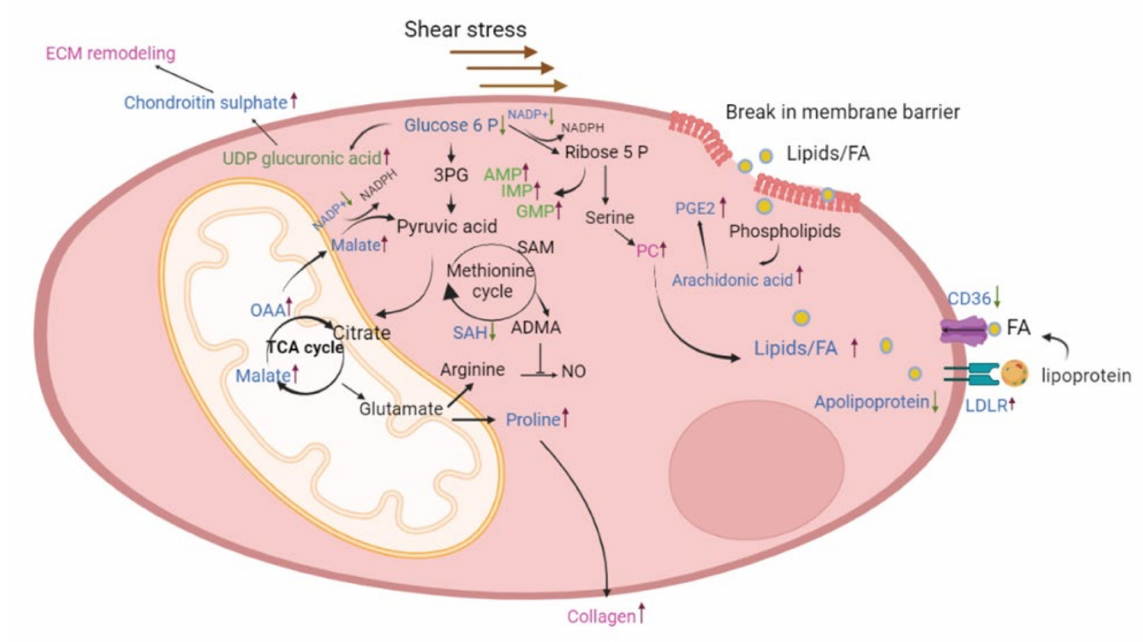
Figure 8. Schematic illustration of the metabolic pathways altered in PVB. The blue-labeled metabo- lites and proteins are differentially expressed in the upper lobe, which is under high shear stress, and the green-labeled ones are differentially expressed in the lower lobe, which is under low shear stress. Pathways or metabolites/proteins labeled in red are found to be altered in both the lobes. 3PG—3- phosphoglyceric acid, SAM—S-adenosyl methionine, SAH—S-adenosylhomocysteine, NO—nitric oxide, PC—phosphatidyl choline, OAA—oxaloacetic